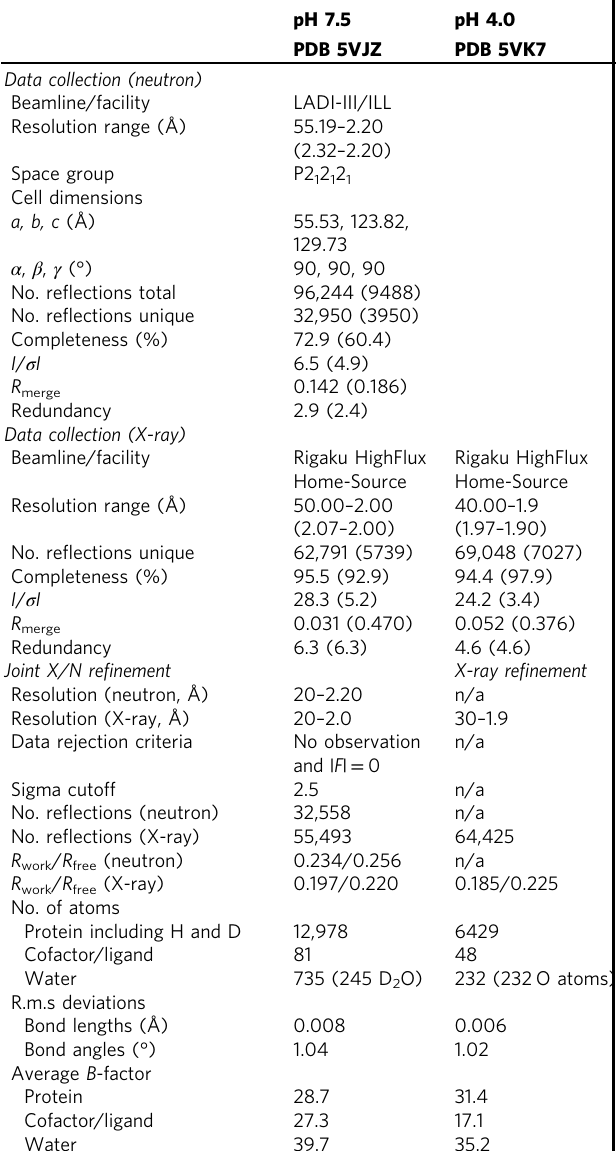
Table 1 X-ray and neutron crystallographic data collection and re fi